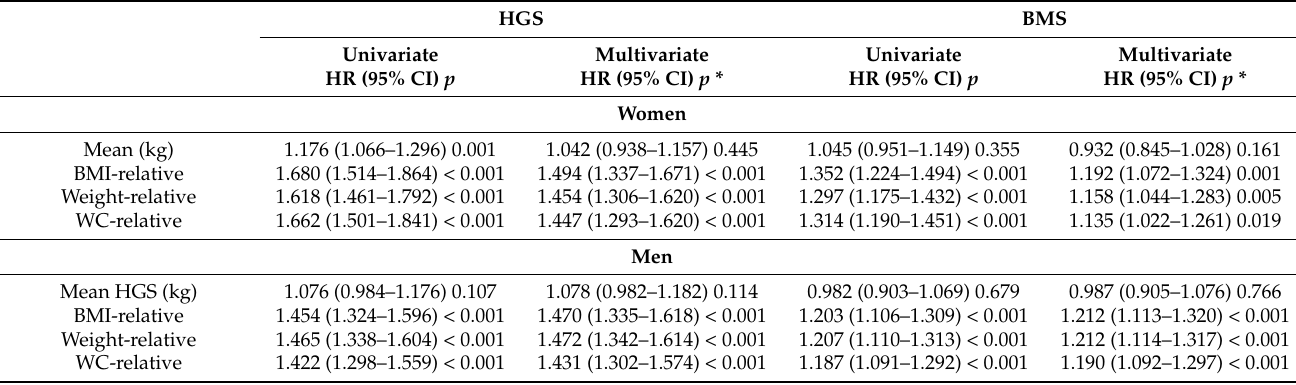
Table 2. Adjusted hazard ratio (HR) of incident metabolic syndrome associated with inverse one standard deviation increase in mean hand grip strength, back muscle strength, and relative muscle strength according to